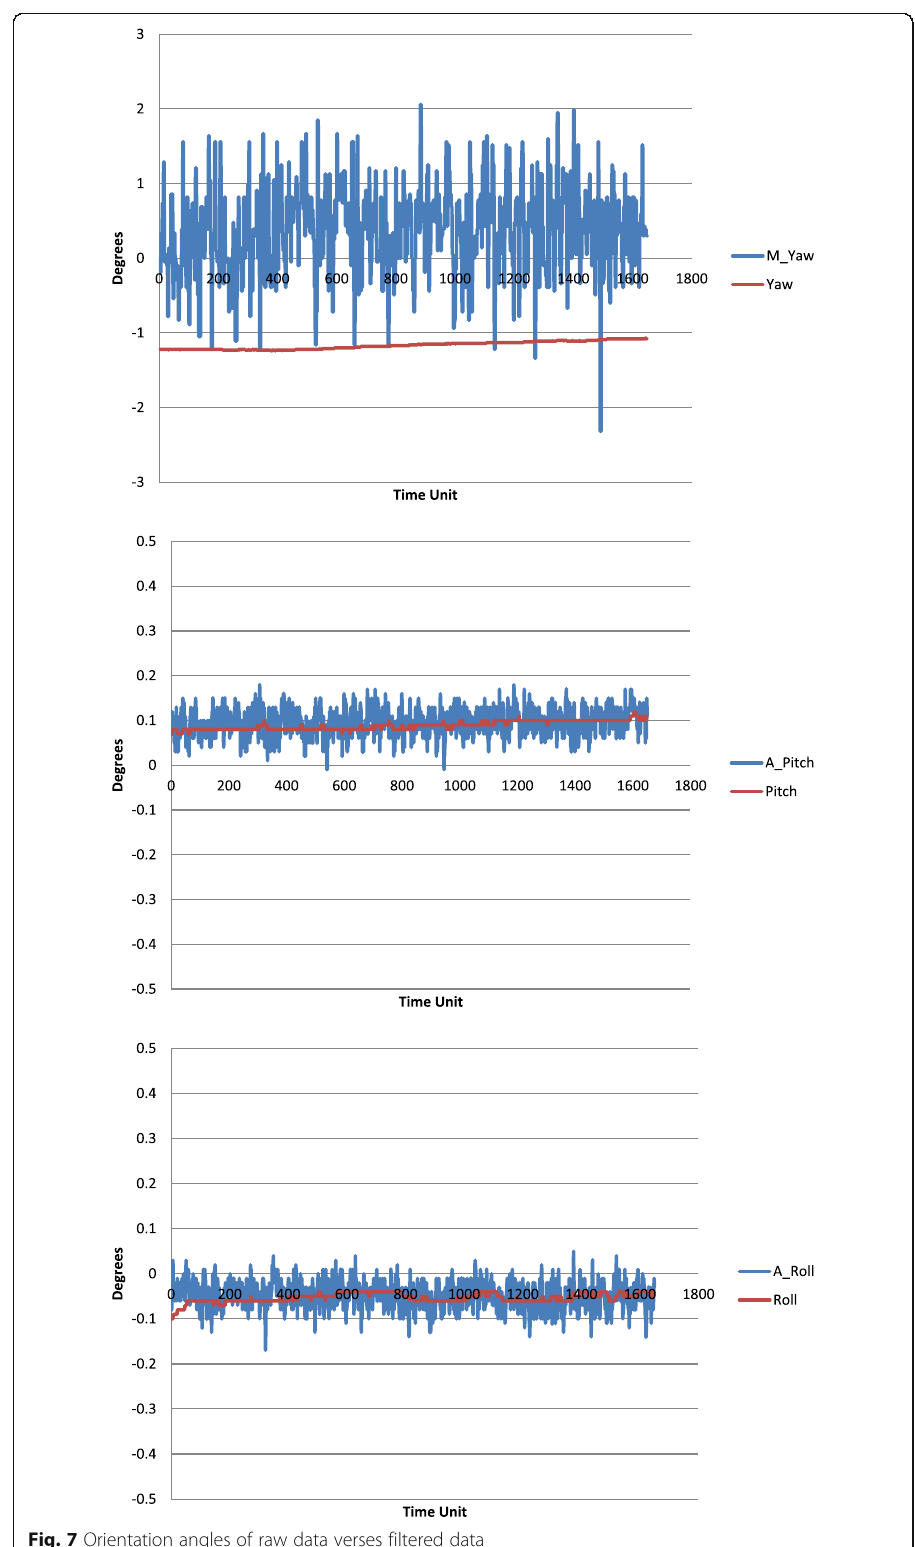
Fig. 7 Orientation angles of raw data verses filtered